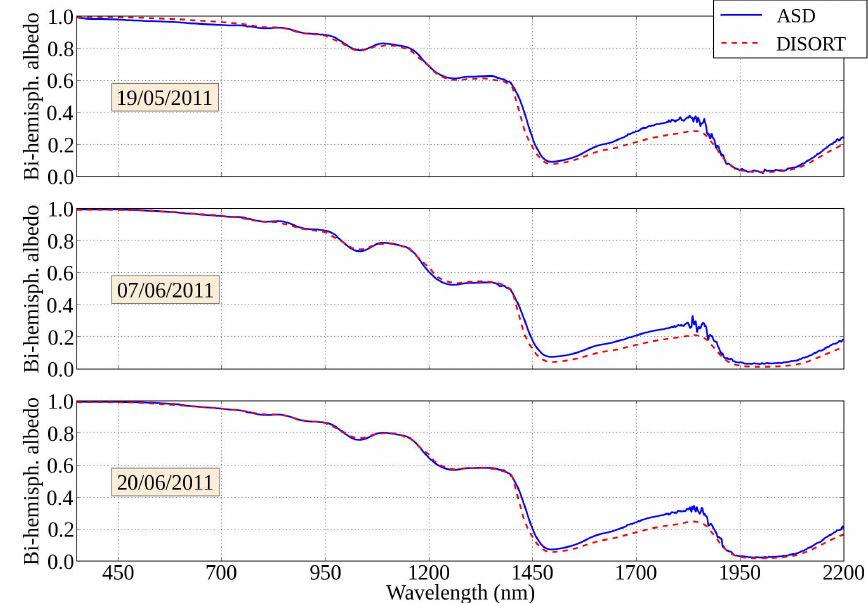
Fig. 9. Measured (solid lines) and simulated (dashed lines) spectral albedo at Summit, for three different dates.